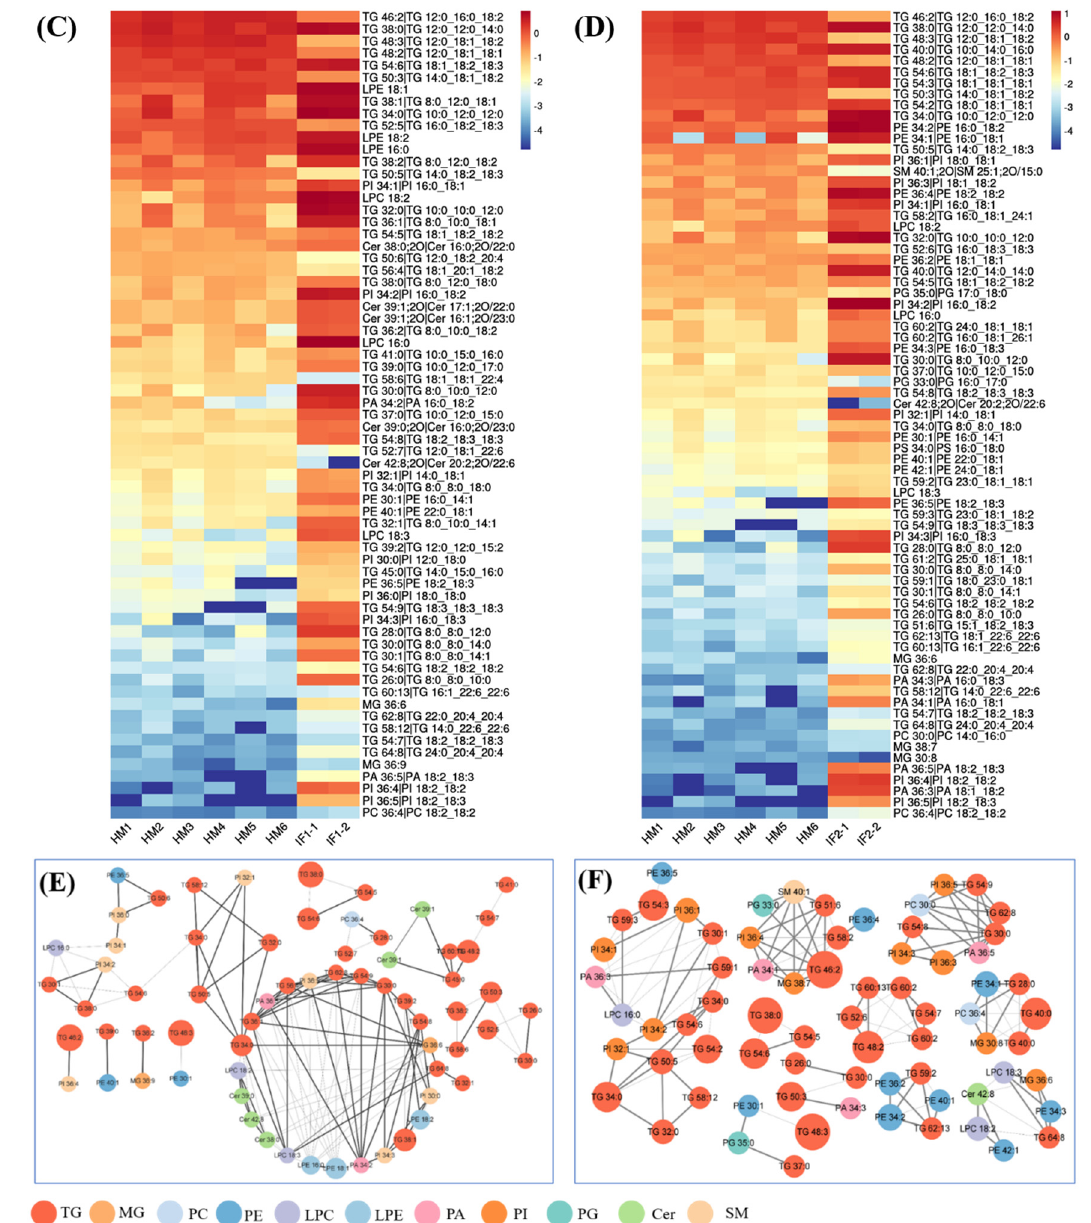
Figure 5. Volcano plot of differential lipids among HM and IFs ( A ). Red represents upregulated, and green represents downregulated. Venn diagrams of VIP, P-value, fold change results of HM and IFs ( B ); heatmap analysis of 67SDLs between HM and IF1 ( C ); 73 SDLs between HM and IF2 ( D ); correlation network ( p < 0.05) of 67 SDLs in HM ( E ); and a correlation network of 73 SDLs in HM ( F ). The size of circle and width of line indicate the level of content and correlation. VIP, variable importance in projection; FC, fold change; P, P-value; SDL, significantly differential lipid; HM-IF1; comparison between HM and IF1; HM-IF2, comparison between HM and IF2.